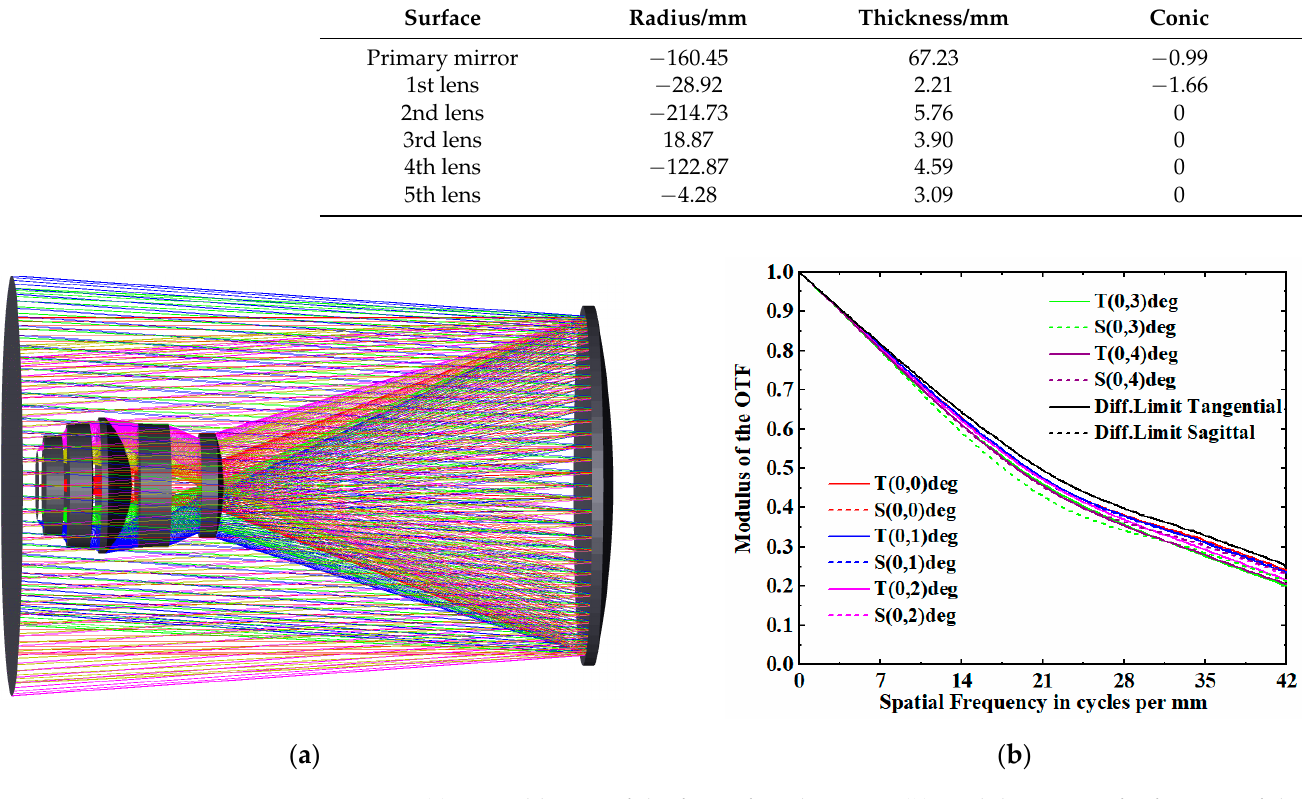
Figure 4. ( a ) Optical layout of the fore-infrared system. ( b ) modulation transfer function of the fore-infrared system.